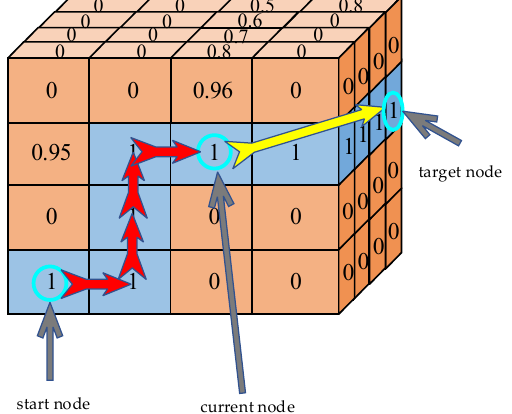
Figure 2. The schematic diagram of interwell-connected path with fused seismic multi-attribute .